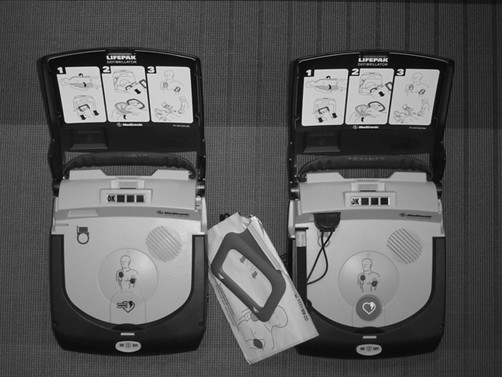
Evaluated automated external defibrillator: (left) automatic mode and (right) semiautomatic mode. Weight: 2.1 kg; physical dimensions: 10 × 20 × 24 cm.